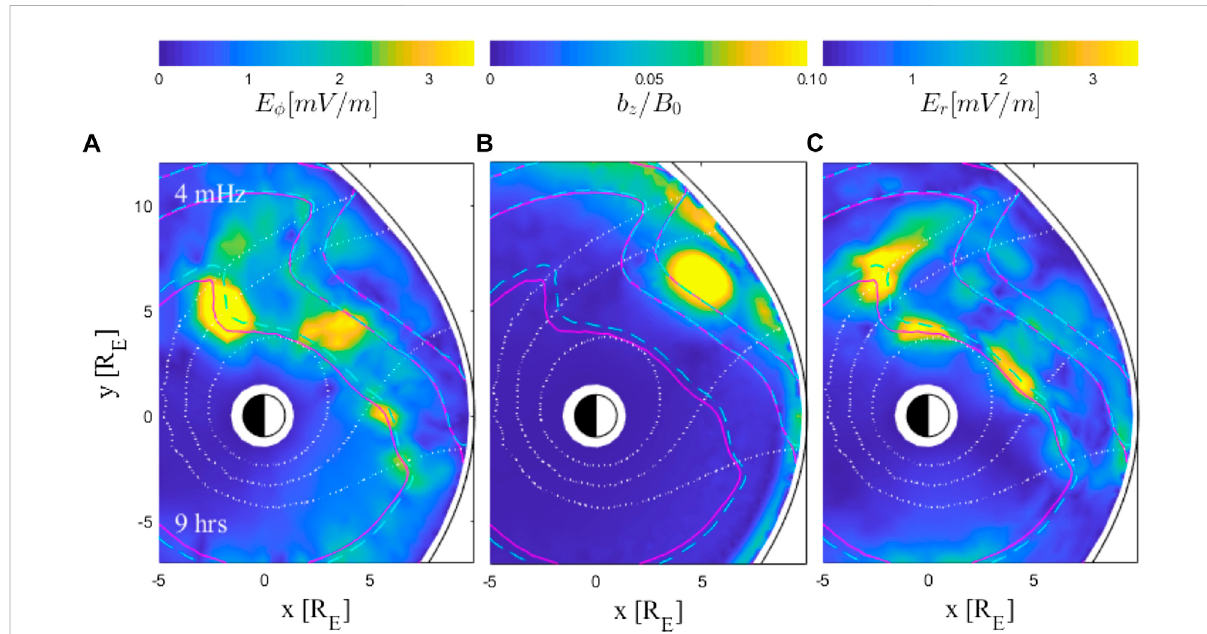
FIGURE 9 (A – C) (Reproduced from Degeling et al. (2018), Figures 2J – L): Equatorial amplitude maps of the ULF wave components E ϕ , b z / B 0 and E r computedusingthemodelofDegelingetal.(2018)forcontinuousexternallydriven4